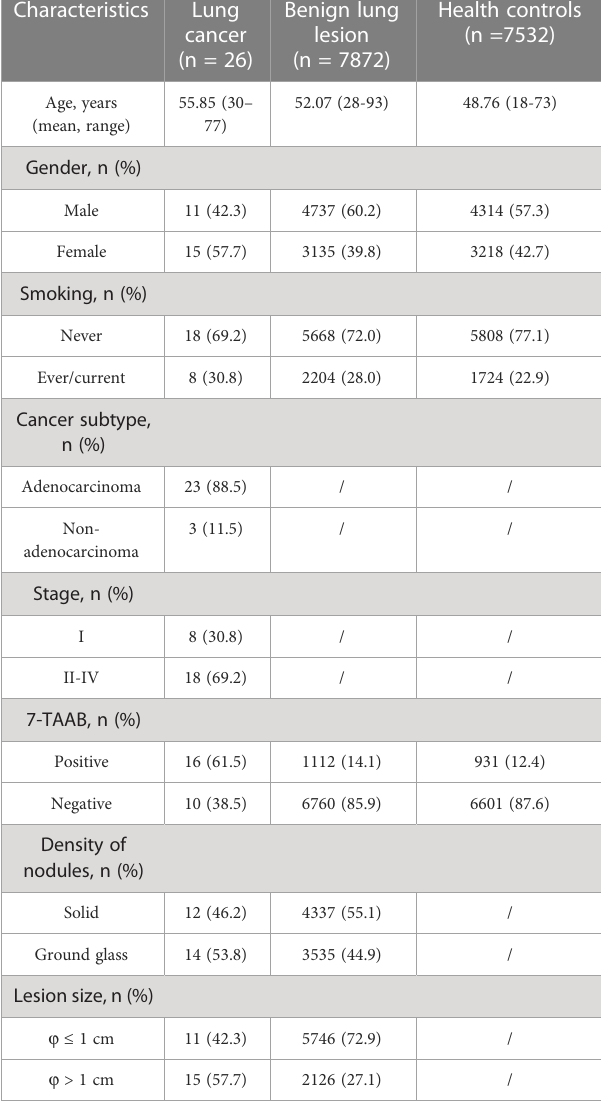
TABLE 1 Clinical characteristics of the physical examination population after a 12-month follow. Characteristics